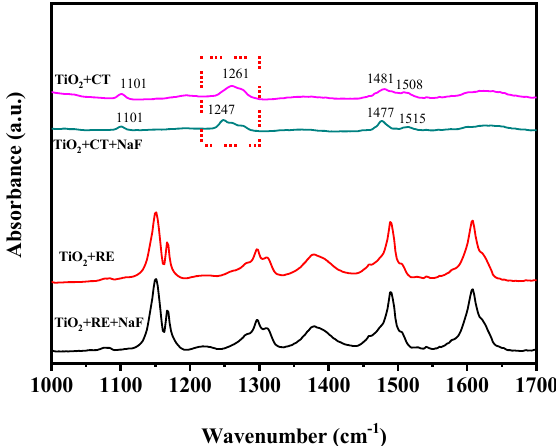
Figure 5. FTIR spectra of TiO 2 after adsorption of CT or RE in the presence or absence of NaF.